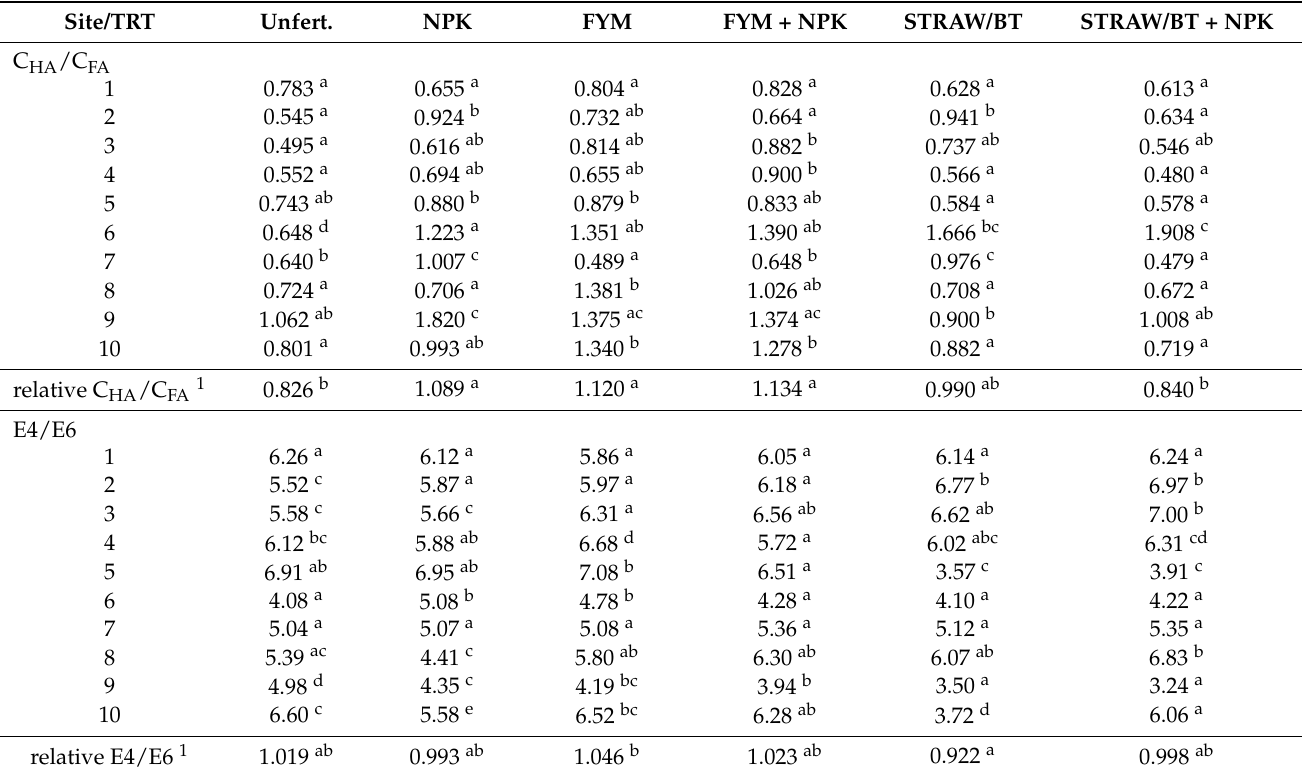
Table 5. The C HA /C FA and E4/E6 ratio in soil at the individual experimental sites.